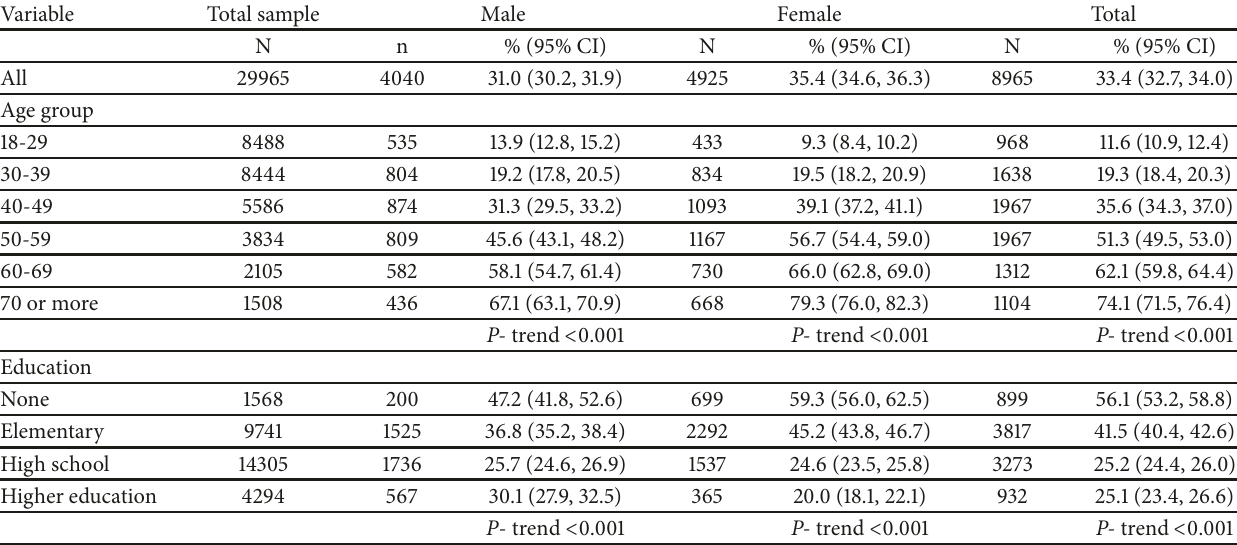
Table 2: Prevalence of hypertension among individuals 18 years and older in